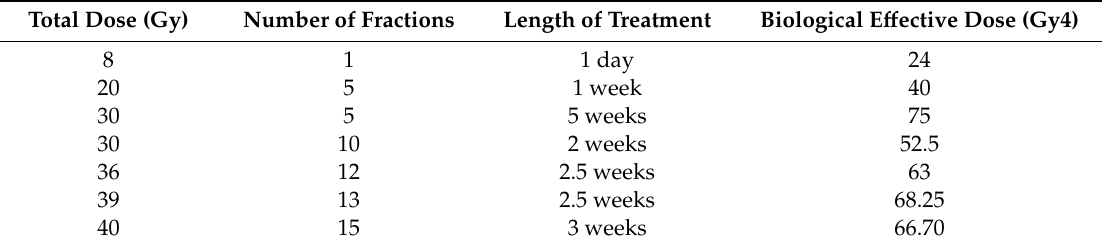
Table 5. Royal College of Radiologist recommended palliative dose and fractionation schedules for